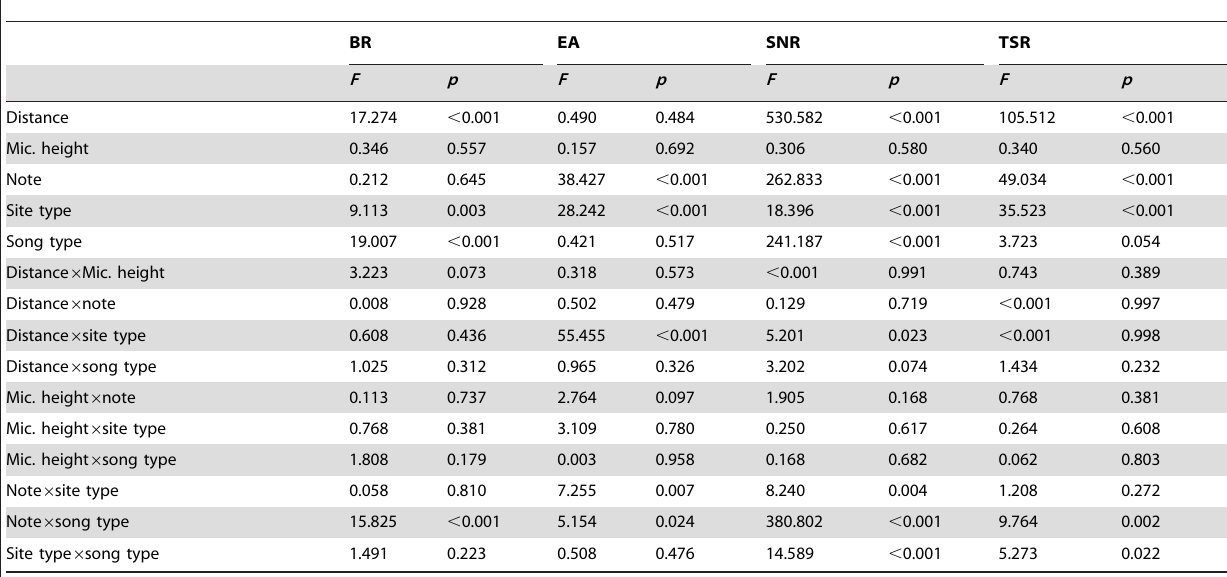
Table 1. Factorial ANOVA table of experiment 1 showing the main effects and two-way interactions of all the variables on the four measurements of